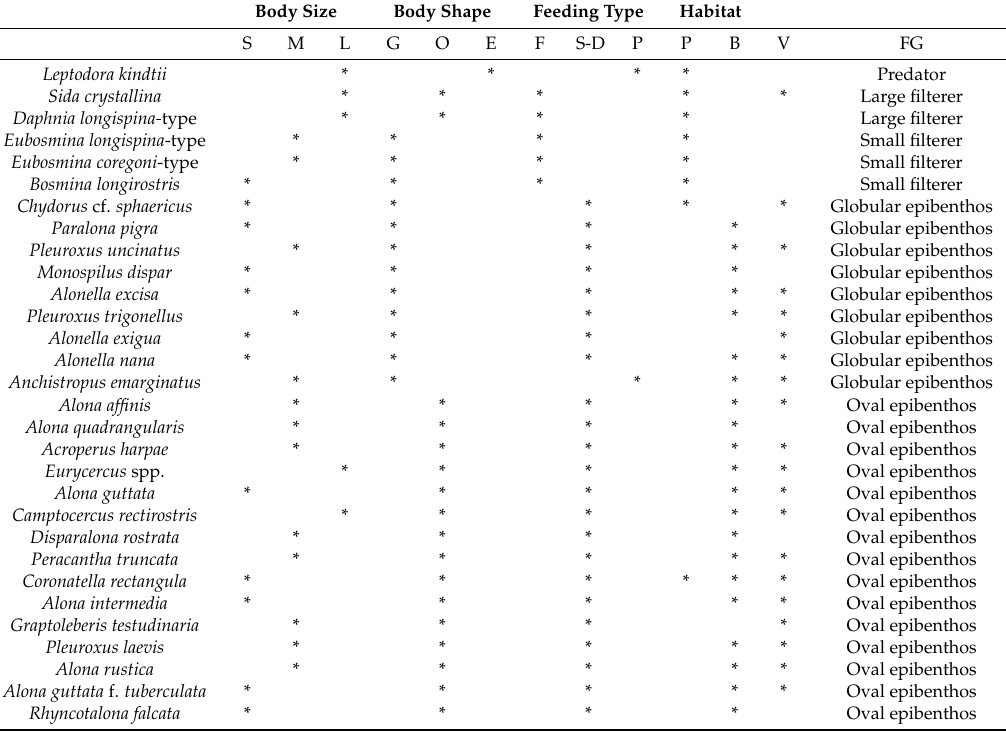
Table 1. Functional characterization of cladoceran taxa (indicated with asterisks) encountered from Lake Maggiore sediment core based on body size (S = small, M = intermediate, L = large), body shape (G = globular, O = oval, E = elongated), feeding type (F = filterer, S-D = scraper-detritivore, P = predator, including parasitism), and habitat (P = pelagial, B = benthic, V = vegetation) and their functional grouping (FG) used in Figure 4. Among each functional group, the taxa are listed according to their mean relative abundance from the most abundant at the